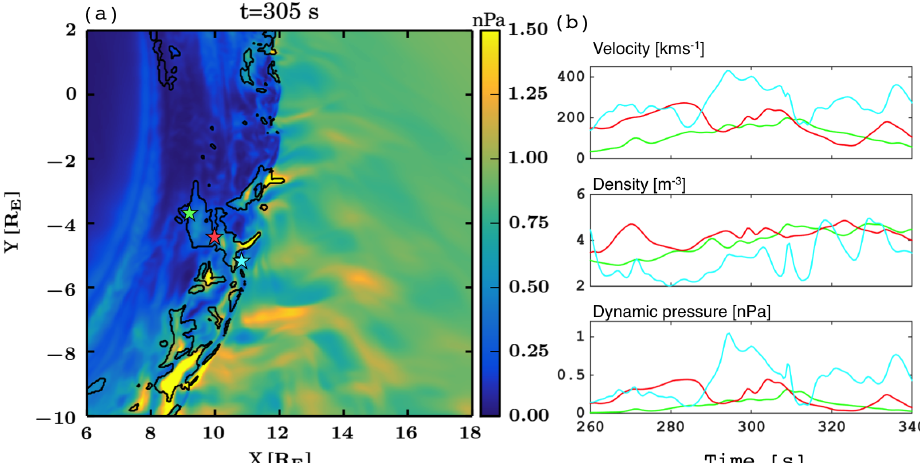
Figure 7. Jet evolution in time as a function of distance from the bow shock. (a) An overview plot of the dynamic pressure with the Plaschke criterion with black contour, at time t = 305s. The panel (a) shows three locations with a green, red, and cyan star, at which virtual spacecraft data are given in panel (b) , showing from top to bottom the velocity, density, and dynamic pressure against time. Color coding shows the data from the similarly colored stars in panel (a) .